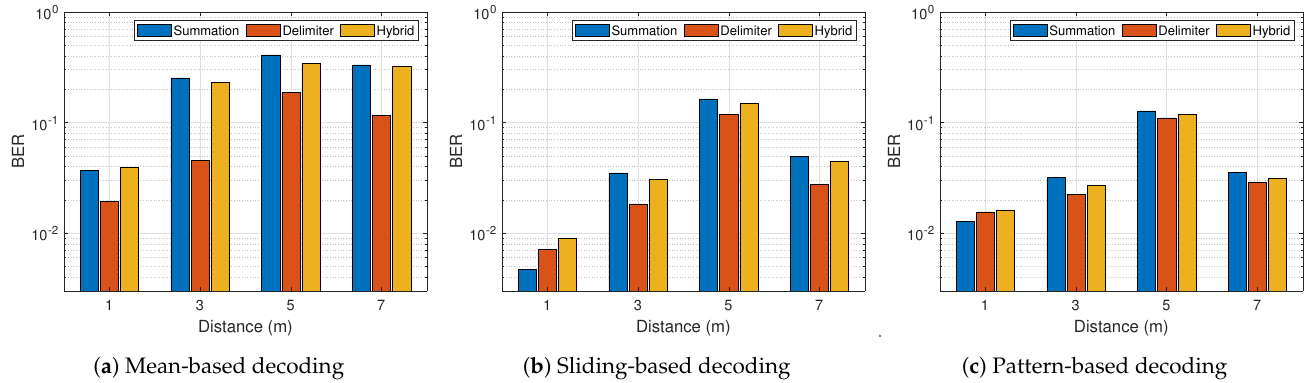
Figure 16. Results comparison for various proposed schemes at 100 kbps with different decoding algorithms.